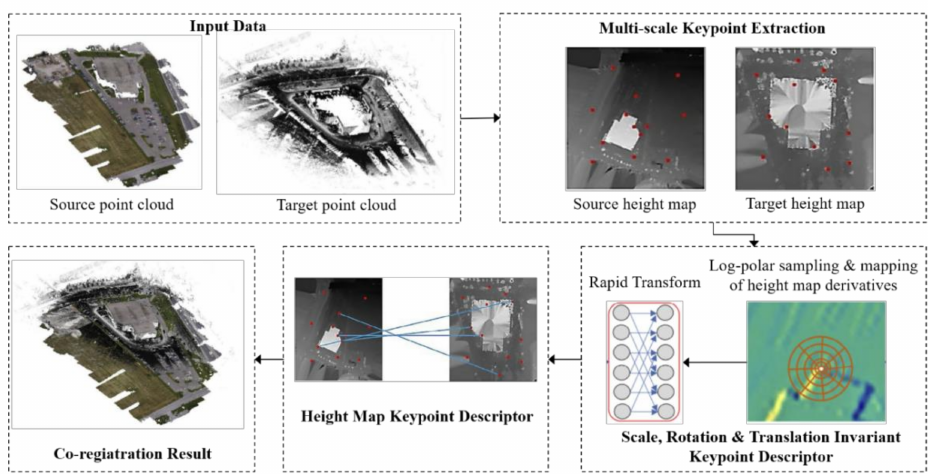
Figure 6. Overview of the height map image point matching approach for co-registering 3D multi-sensor point clouds.